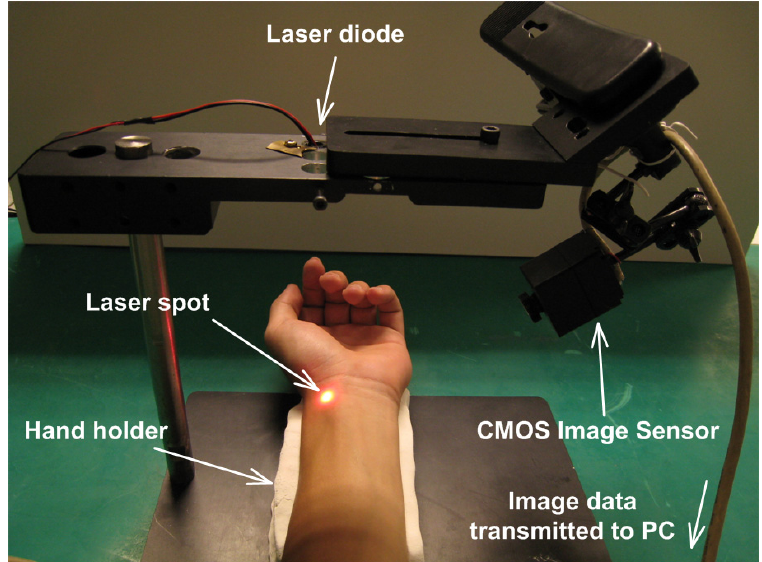
Figure 2. The actual implementation of the proposed APM